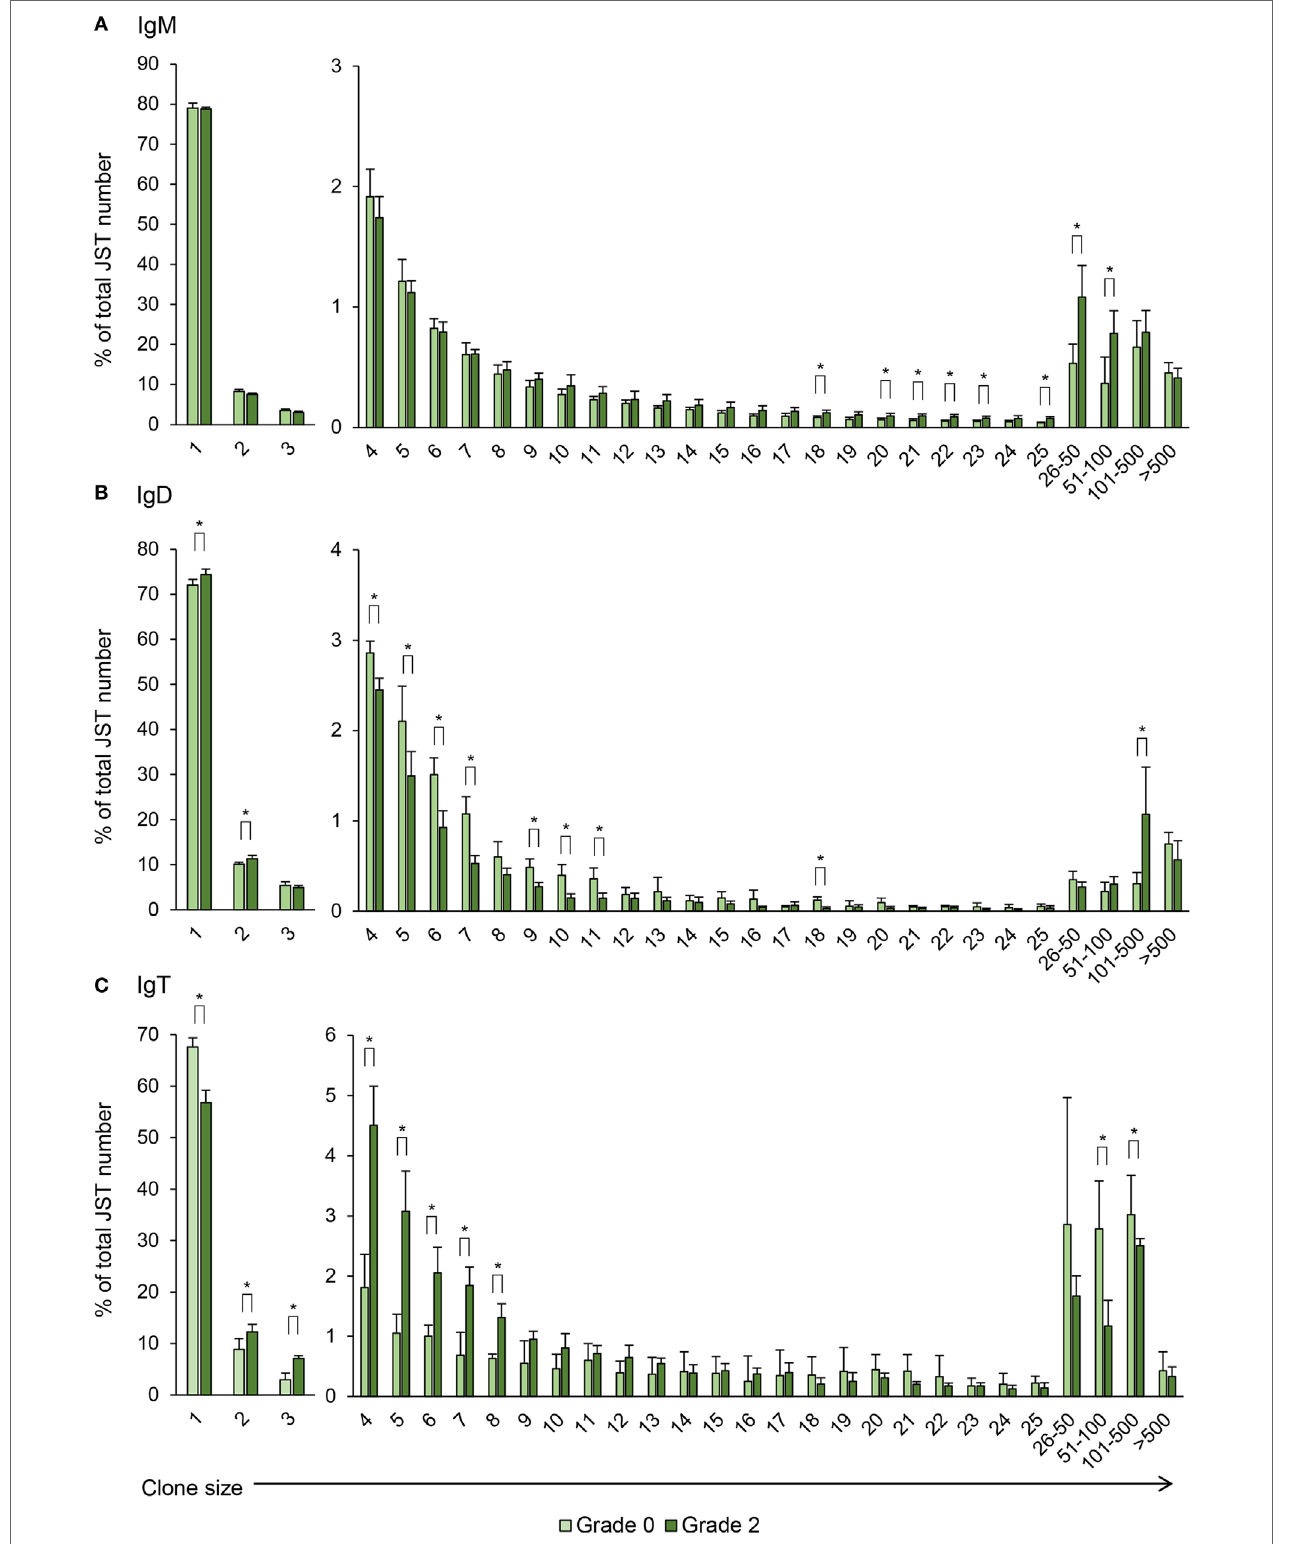
FigUre 9 | Clonal size distribution of junction sequence types (JST) during B cell response to proliferative kidney disease. Bar charts show the average percentage (mean + SD) of JST observed n times in the sequence datasets for IgM (a) , IgD (B) , and IgT (c) from grade 0 kidneys in comparison with grade 2 kidneys ( n = 4). Statistical differences ( P < 0.05) between the two groups (analyzed with a two­tailed Student’s t ­test) are shown with an asterisk.